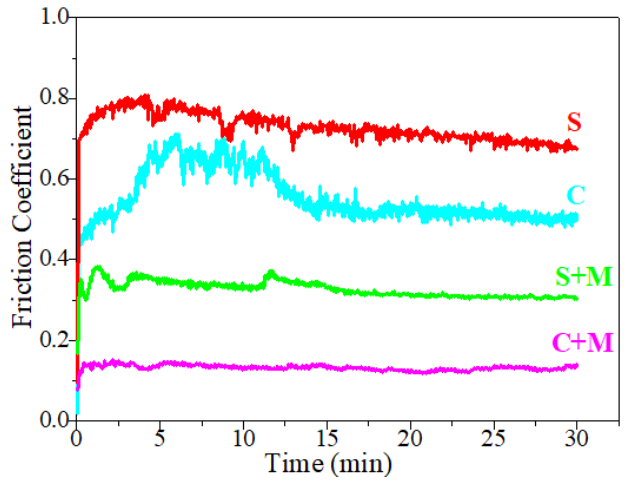
Figure 9. Friction coefficients of slipper substrate and different coatings: S, Slipper substrate, C, Ni80Al20 coating, S + M, Substrate with MoS 2 film and C + M, Ni80Al20-MoS 2 composite coating.